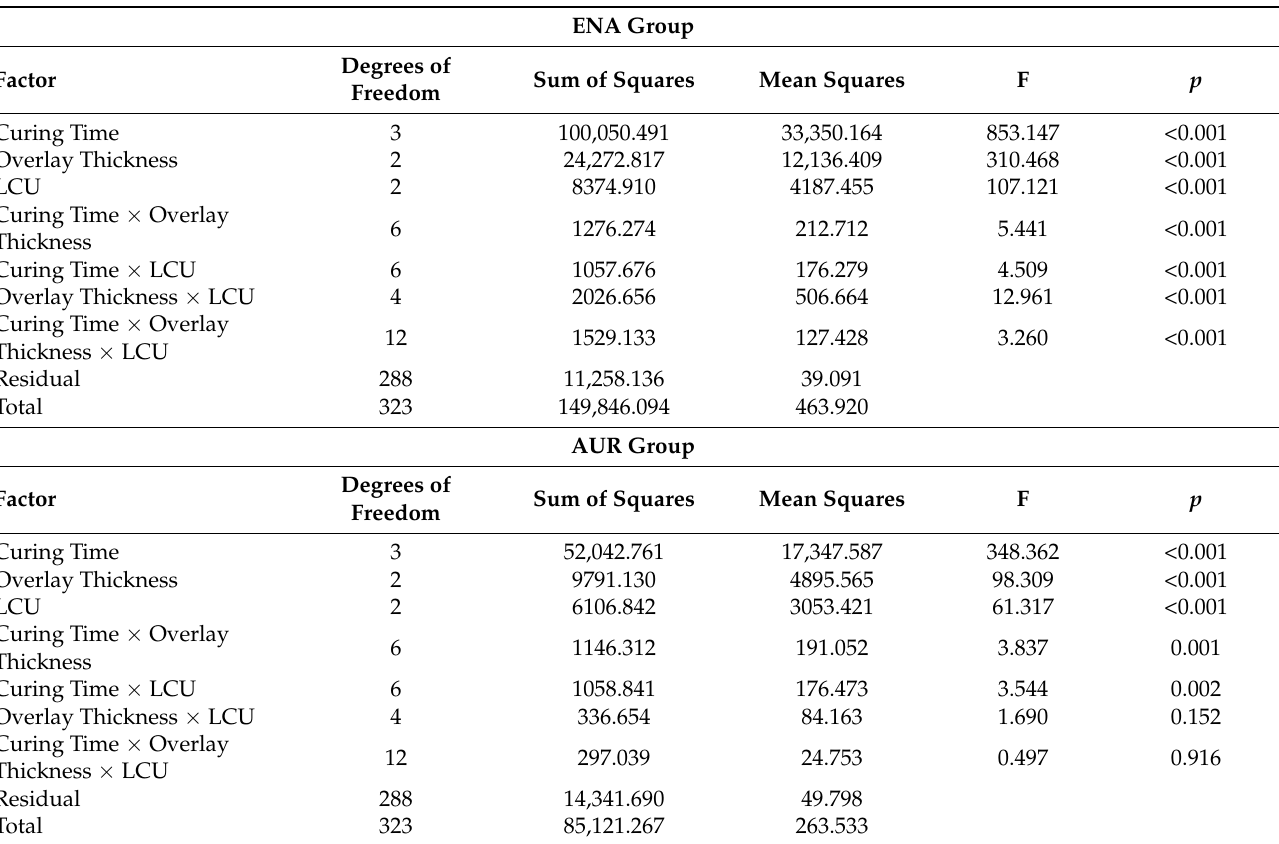
Table 3. Three-way ANOVA tables showing effects of the three variables (curing time, overlay thickness and LCU) on the Vickers Hardness mean